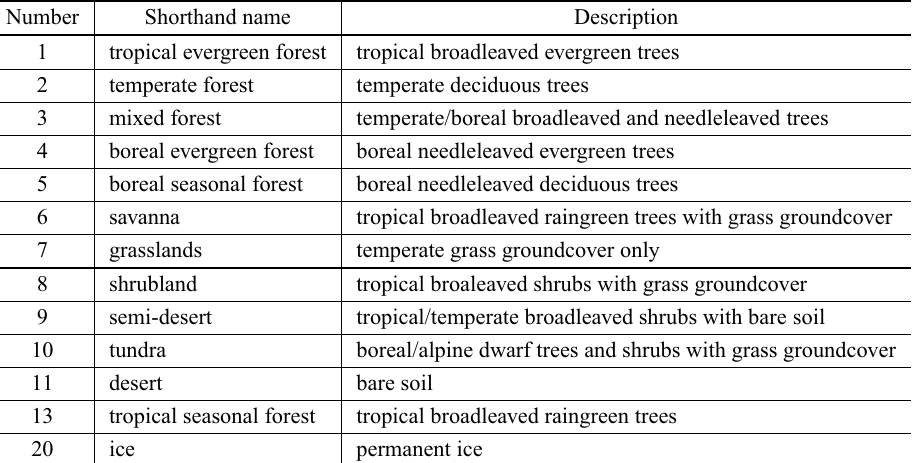
LONS08 vegetation classification.